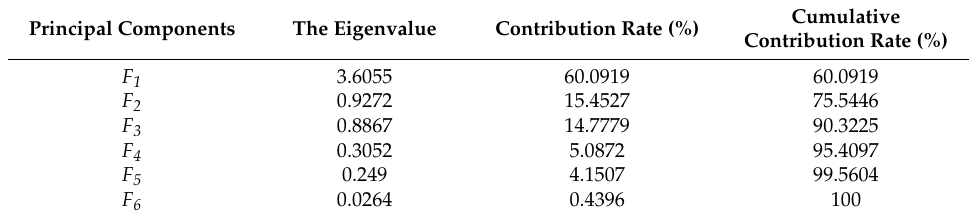
Table 9. Eigenvalue of the correlation coe ffi cient matrix and variance contribution rate.